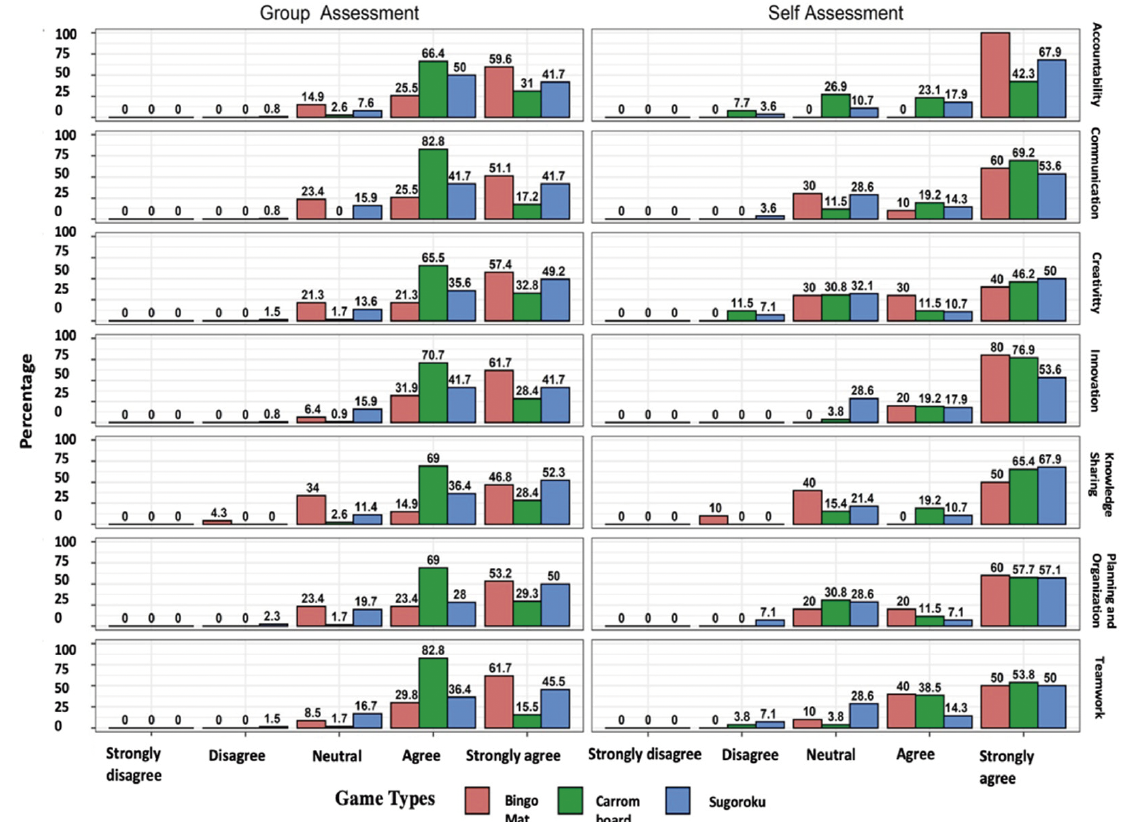
Figure 2. The agreements of participants towards the development of seven generic skills chosen in the solution development step. Attitude comparison between self assessment (N = 64) and group assessment (N = 295) for seven generic skills among three different games developed to teach SDGs (self assessment: Sugoroku = 28; Carrom board = 26; Bingo = 10 and group assessment: Sugoroku = 132; Carrom board = 116; Bingo =